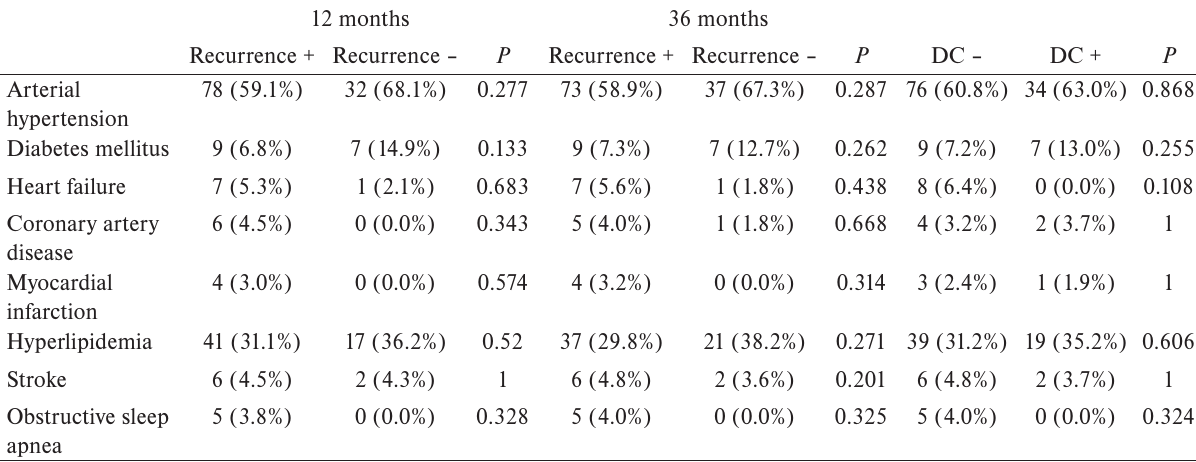
Table 4. The difference in baseline clinical parameters before ablation in patients with and without arrhythmia